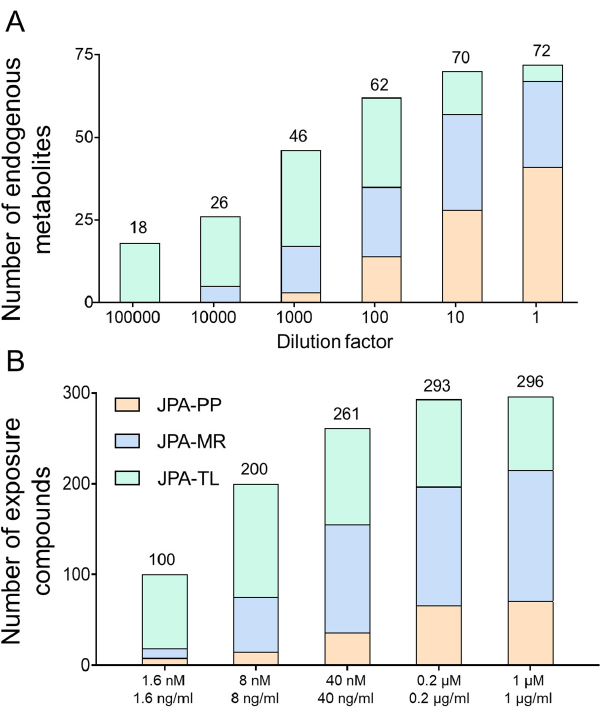
Figure 5. Comparison of ( A ) endogenous metabolite standards and ( B ) exposome chemicals extracted by JPA-peak picking (JPA-PP), JPA-MS 2 recognition (JPA-MR), and JPA-targeted list (JPA-TL).